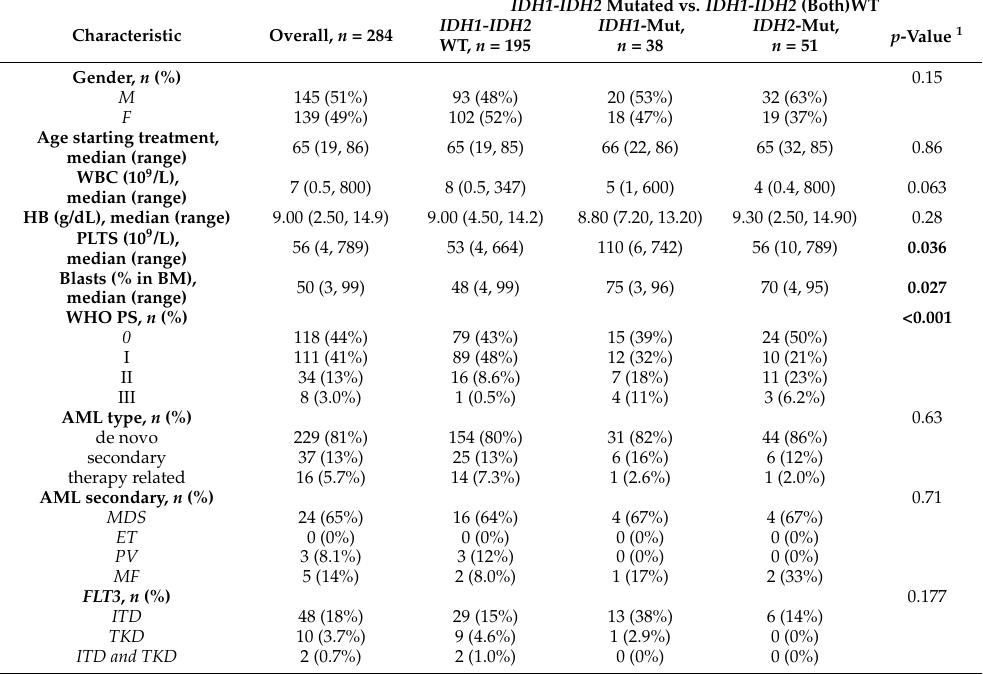
Table 1. Patient characteristics by IDH1 / 2